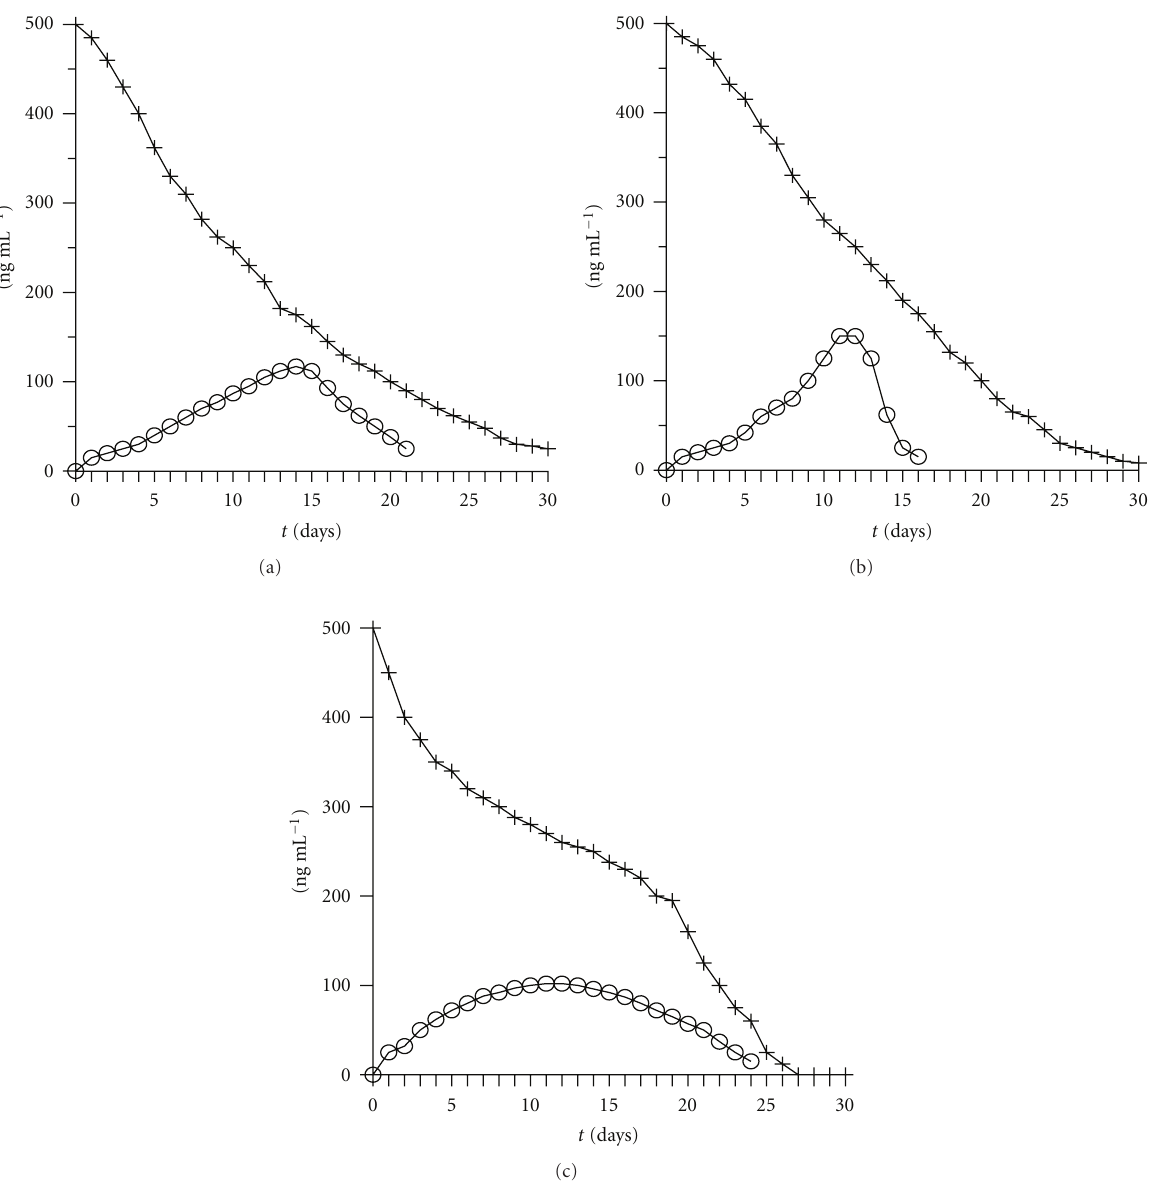
Figure 2: Curves showing the decomposition of carbaryl (+) and the formation of 1-naphthol (o), in (a) water, (b) soil, and (c)